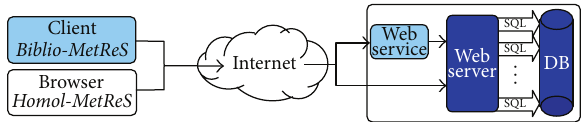
Figure 1: Cloud computing